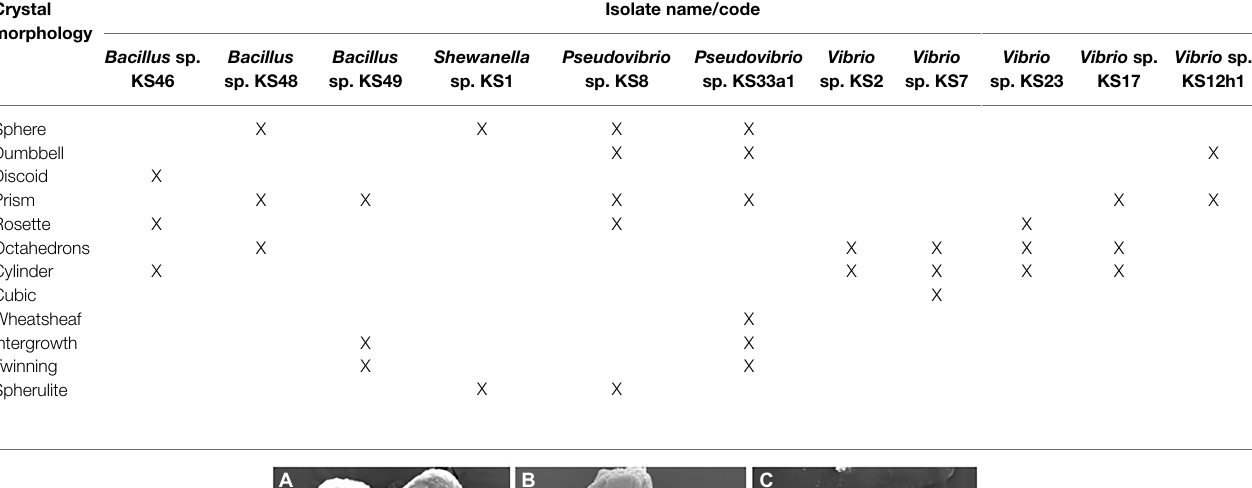
TABLE 1 | Different shapes of calcium carbonate crystal produced by bacteria. Crystal